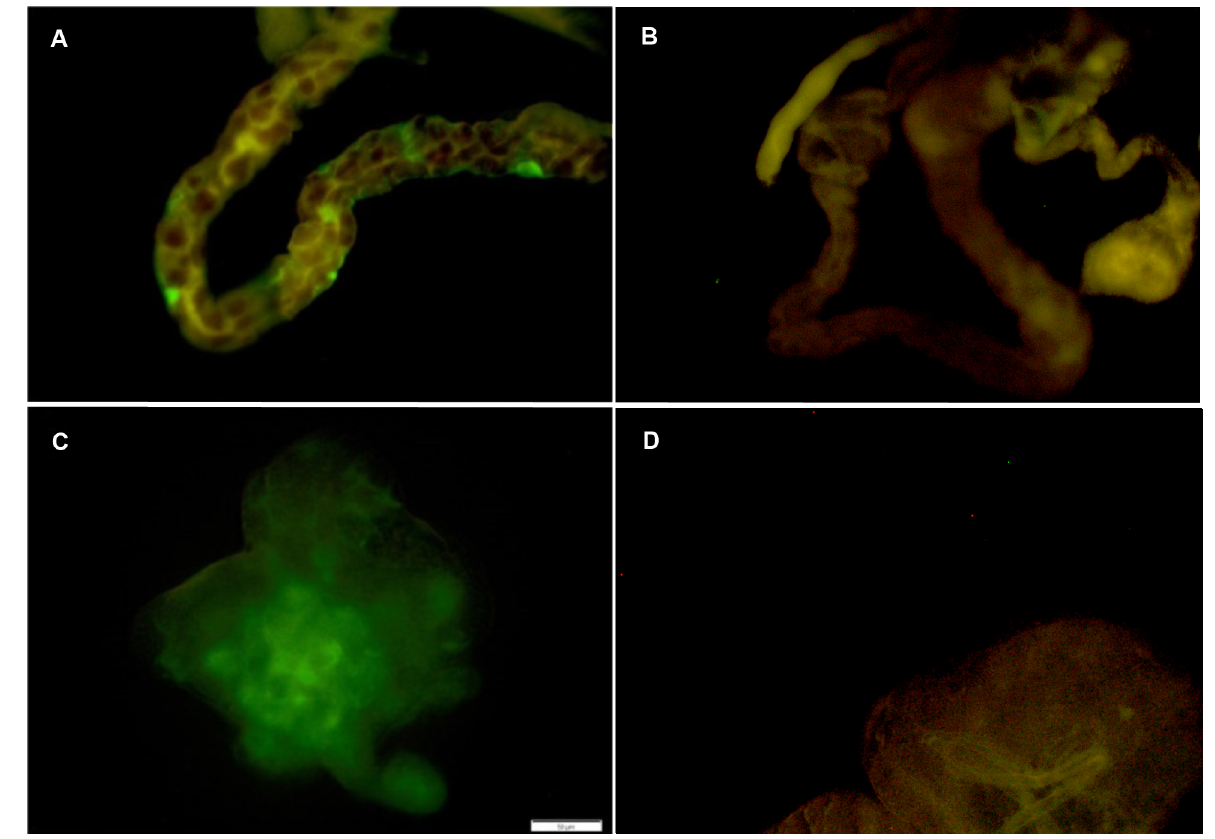
Figure 1. Lso infection in the (A) alimentary canal and (C) the salivary glands of potato psyllids. Green fluoresence indicates the presence of Lso while non-infected tissues appear yellow. Lso non-infected psyllids showed no green fluoresence in the (B) alimentary canal and (D) the salivary glands.